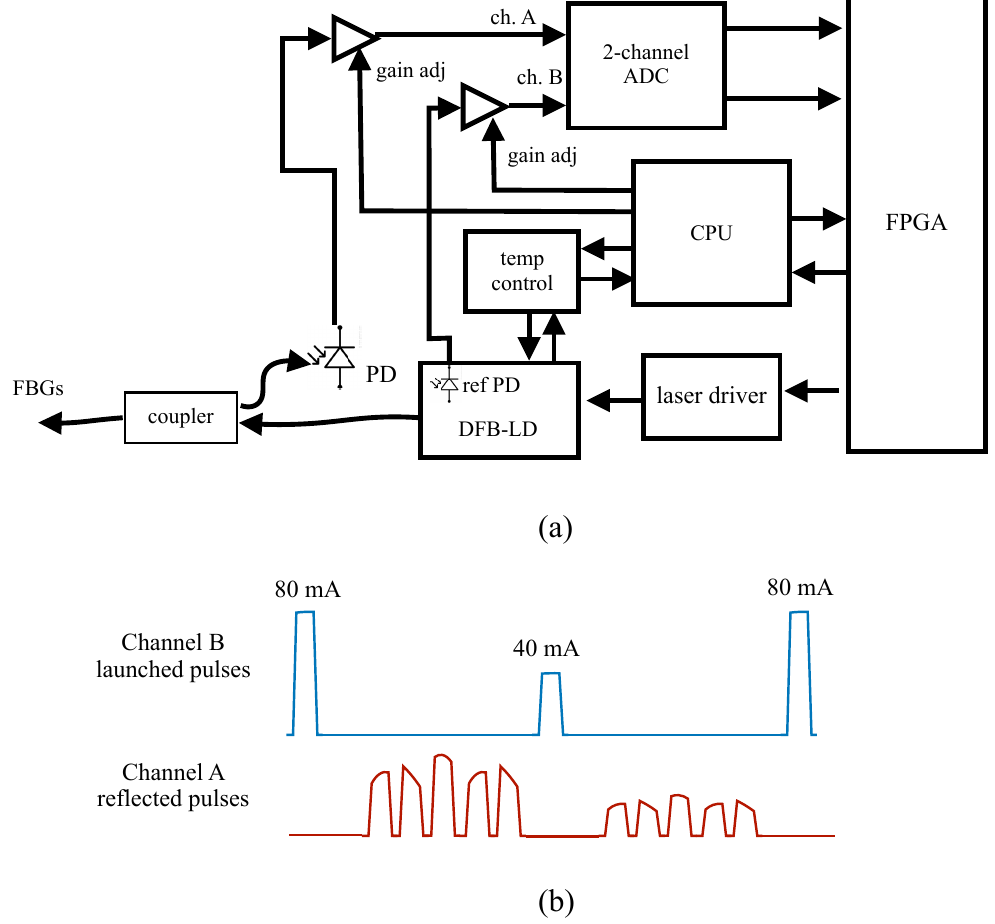
Figure 3. ( a ) Instrument schematic; ( b ) Temporal trace for the emitted pulses detected in channel B of the analog-to-digital converter (ADC), and the reflected pulses detected in channel A (in the case of 5